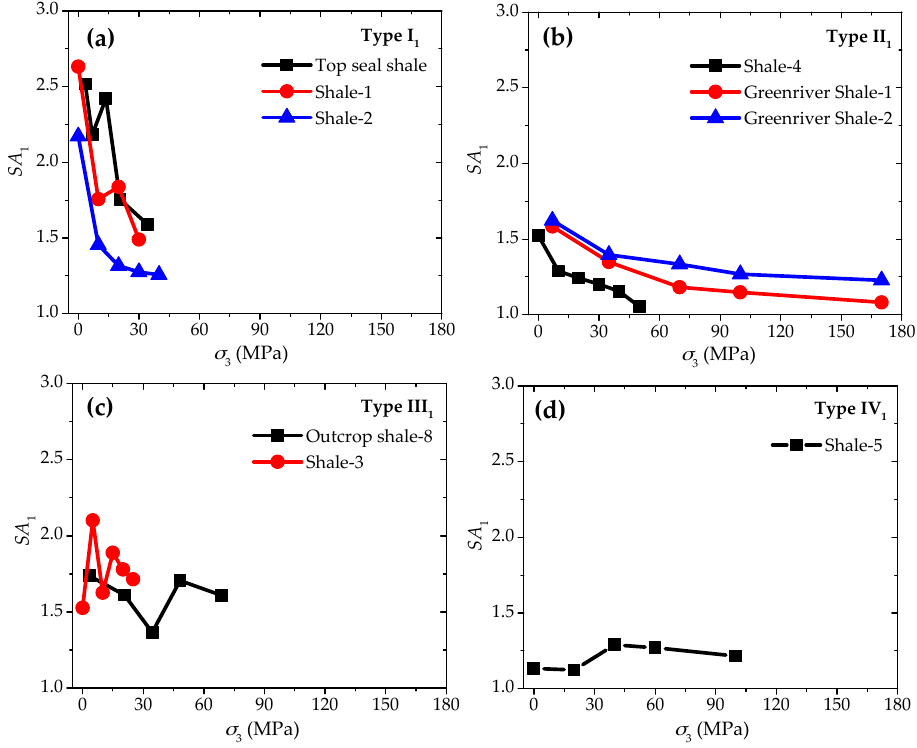
Figure 3. Four types of anisotropic strength behaviors based on SA 1 with increasing confinement.